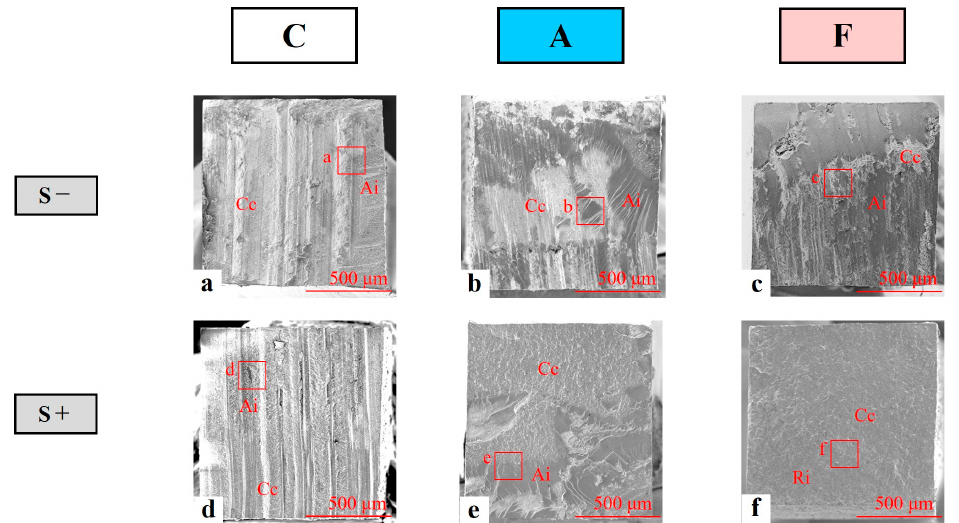
Figure 4. Representative scanning electron microscopy images of the dentin-side surface of the post-test specimens on the occlusal wall (50 × magnification). Interfacial fracture occurred at the interface between the restorative and resin cement (Ri), cohesive fracture occurred within the resin cement (Cc), and interfacial fracture occurred at the interface between the resin cement and the abutment-side surface (i.e., dentin, adhesive, or flowable resin)